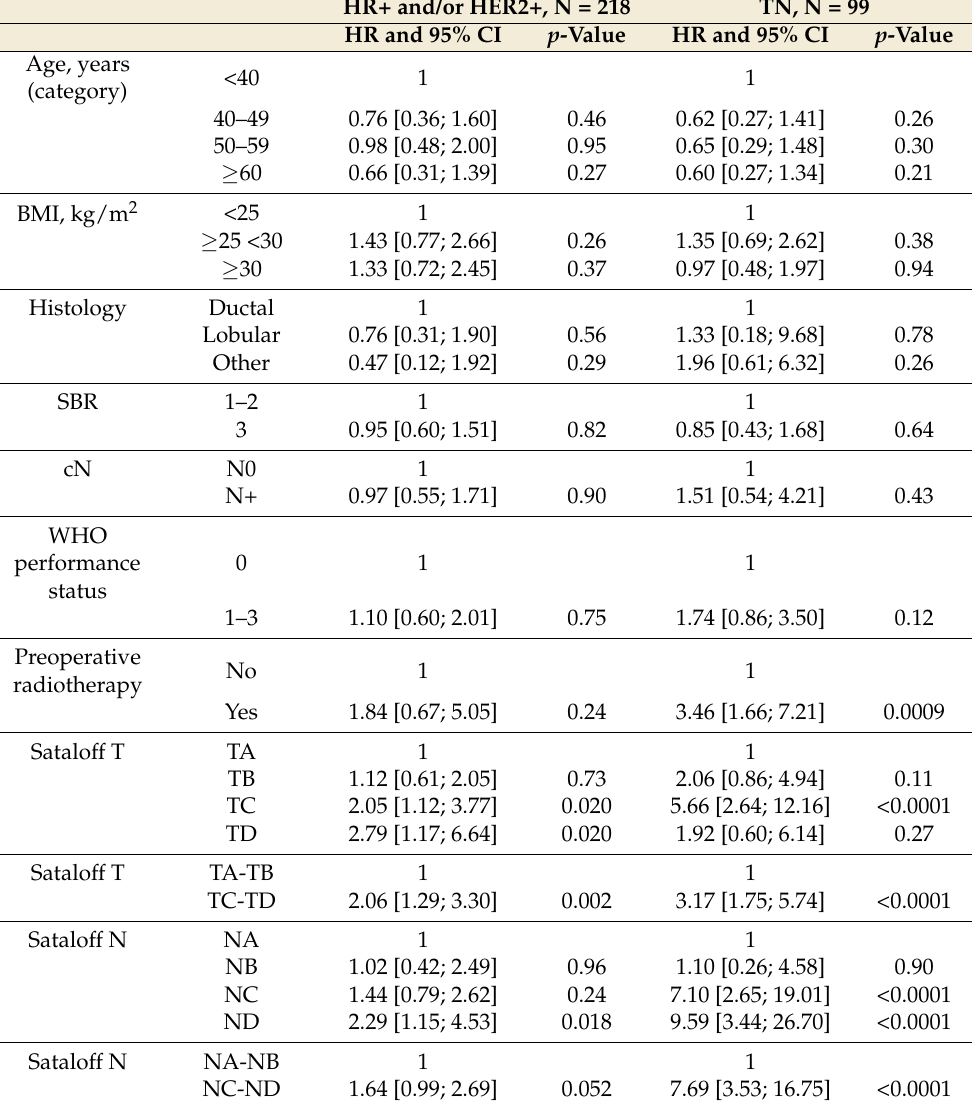
Table 3. Univariate analyses of prognostic factors for disease-free survival (DFS) stratified by triple- negative